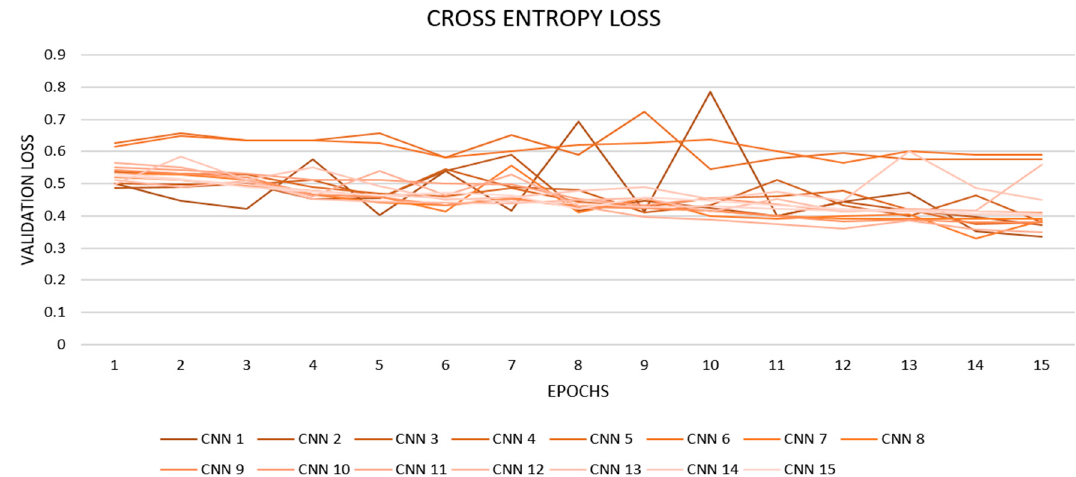
Figure 7. Training curve of validation loss for each CNN architecture per epoch.